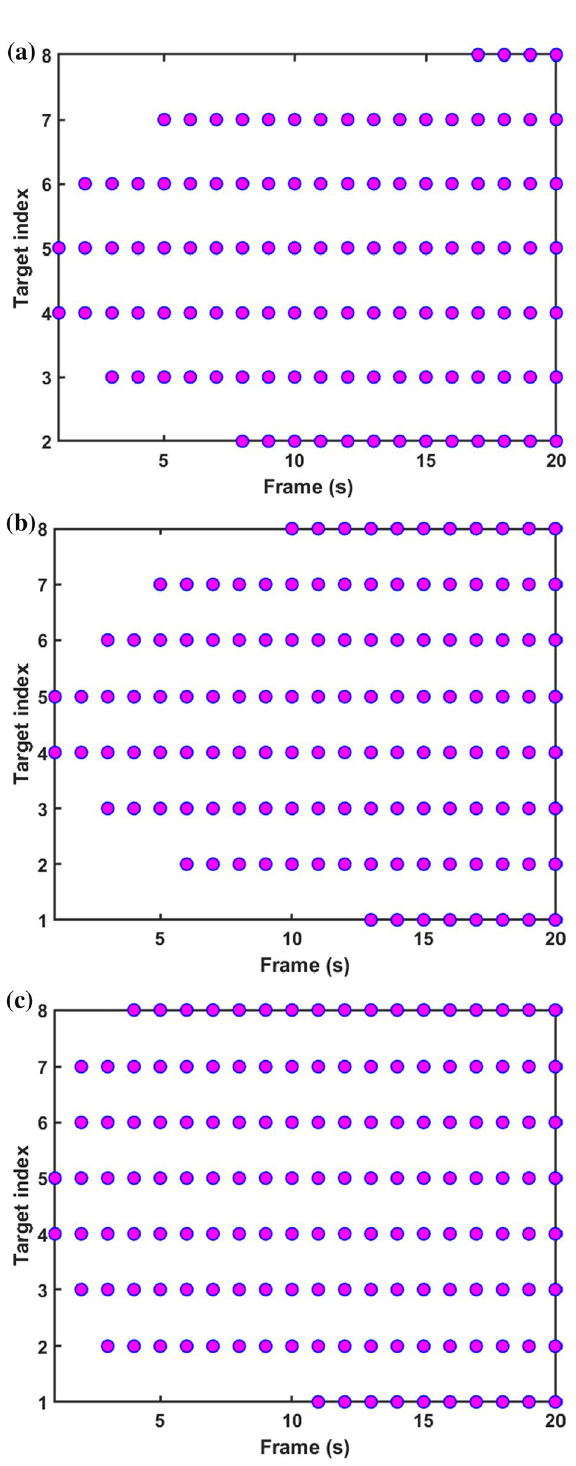
Fig. 5 Indices of the effective tracking targets. a Uniform allocation. b Sum-max optimize allocation. c Proposed RPA